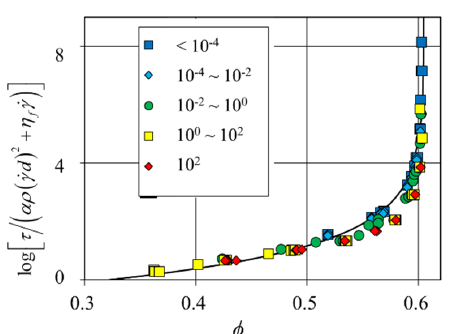
Fig. 6. Parametric plot of measured shear stress values divided by measured normal stress ( 𝜇 (cid:2915)(cid:2916)(cid:2916) (cid:3404) 𝜏 𝜎 ⁄ ) normalized by K (Eqn. 7) plotted vs. measured solid fraction. Legend is 𝐽 / 𝐼 (cid:2870) . Solid line is best fit power law (Eqn. 10). Assuming a constant solid fraction in the fine